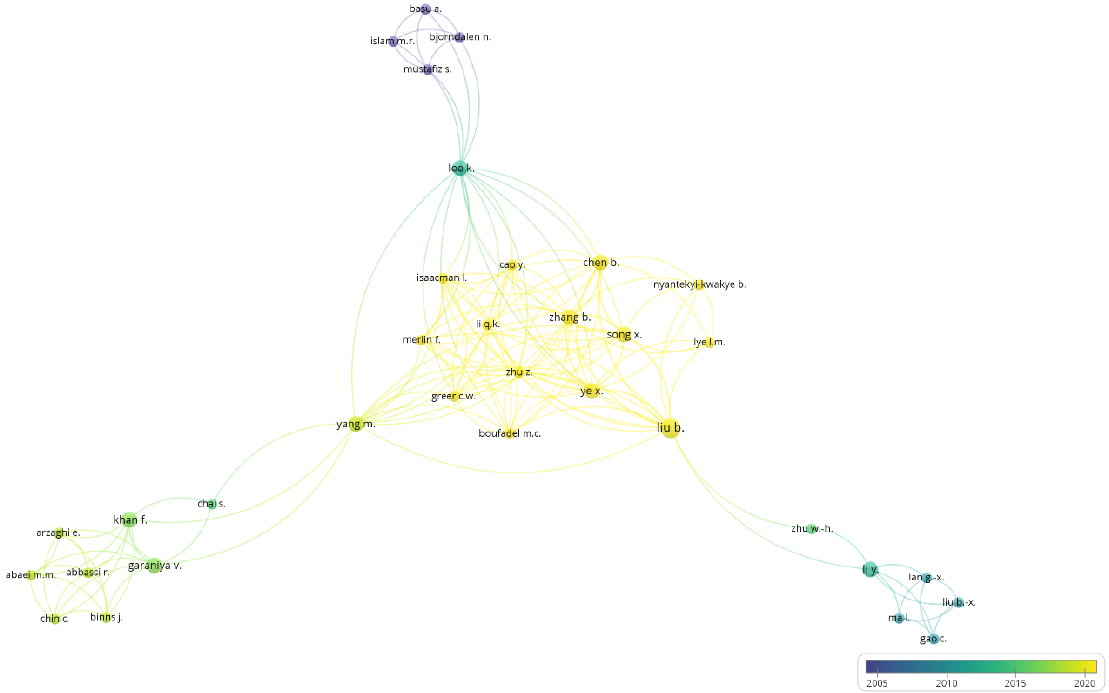
Figure 2. Authors’ cooperation network in oil spills research in ice ‐ infested waters.